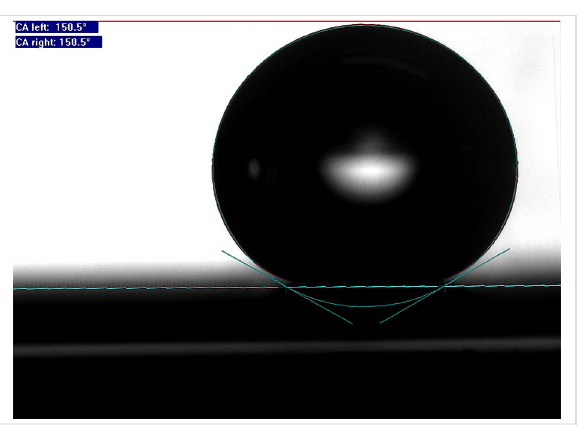
Figure 3: Contact angle of water on the sprayed coating, before charging. Because there are many KPFM images (CPD) for the whole